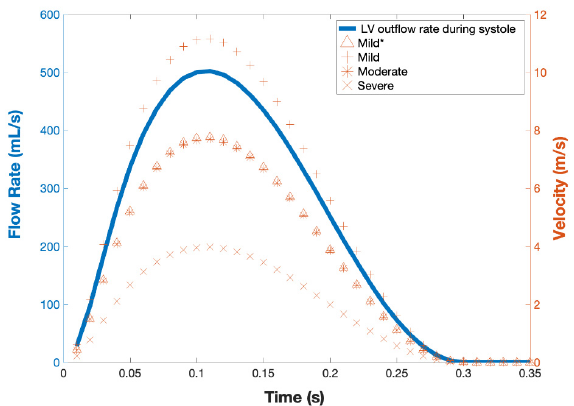
Figure 2. The scatter plots for the prescribed left ventricular (LV) outflow rate in a healthy subject during systole and the velocity profiles over time for different severity cases.